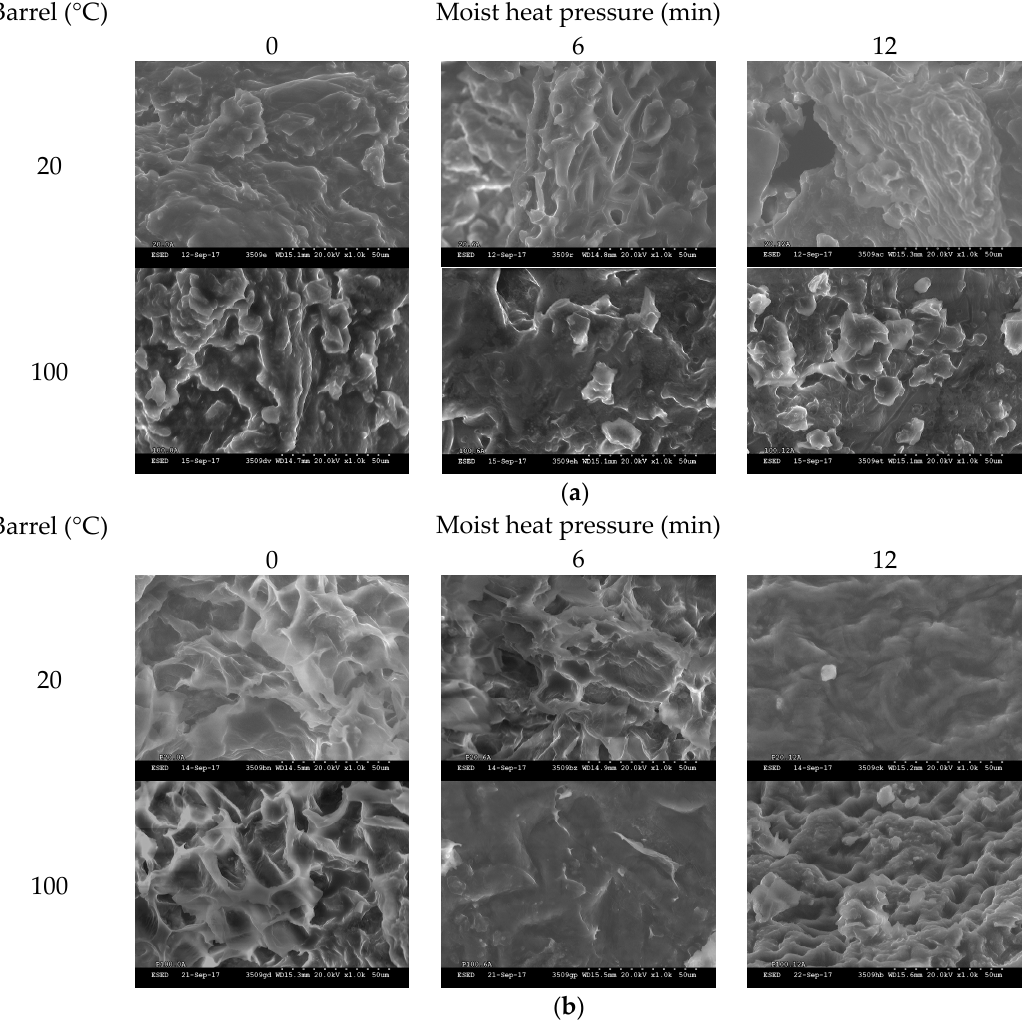
Figure 3. Representative scanning electron photomicrographs of cold-pressed (20 °C) and expeller (100 °C) meal treated with increasing durations of moist heat pressure ( a , 0, 6 or 12 min) post proteolytic digestion ( b ). Images were taken with ×1.0 k resolution.